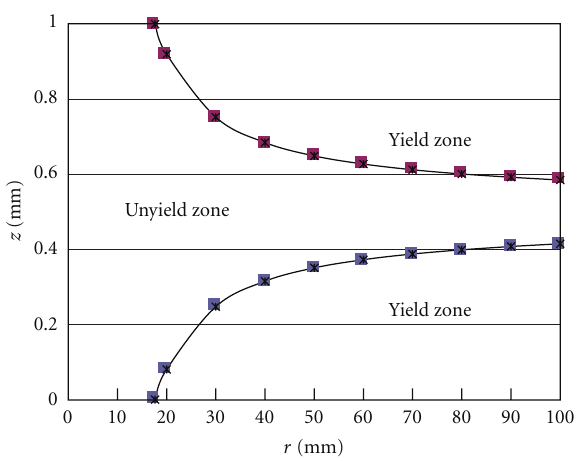
Figure 6: The yield surface along the radial direction.